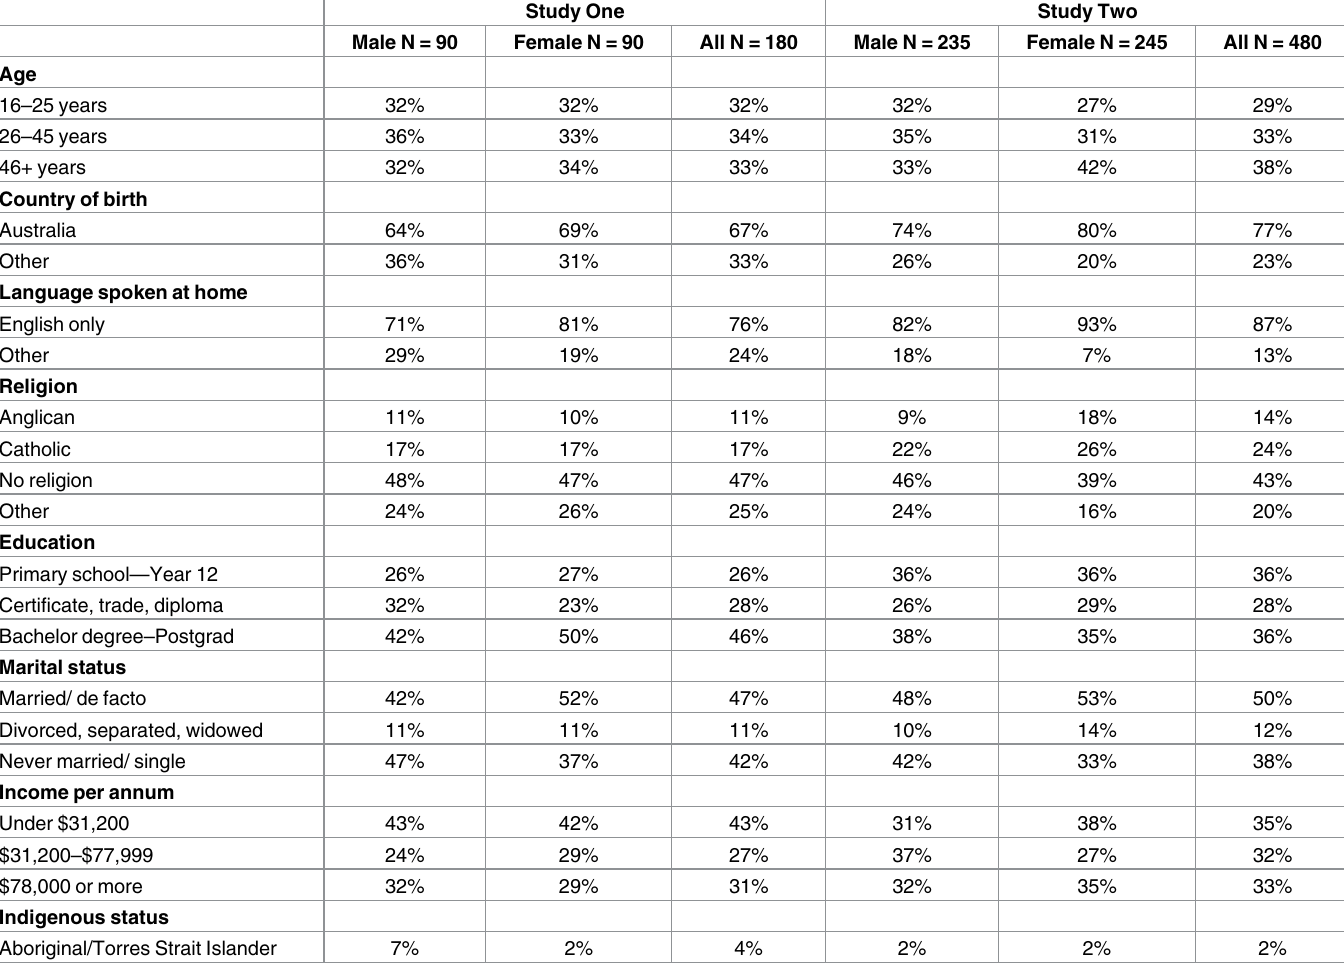
Table 2. Demographic details of Study One and Study Two